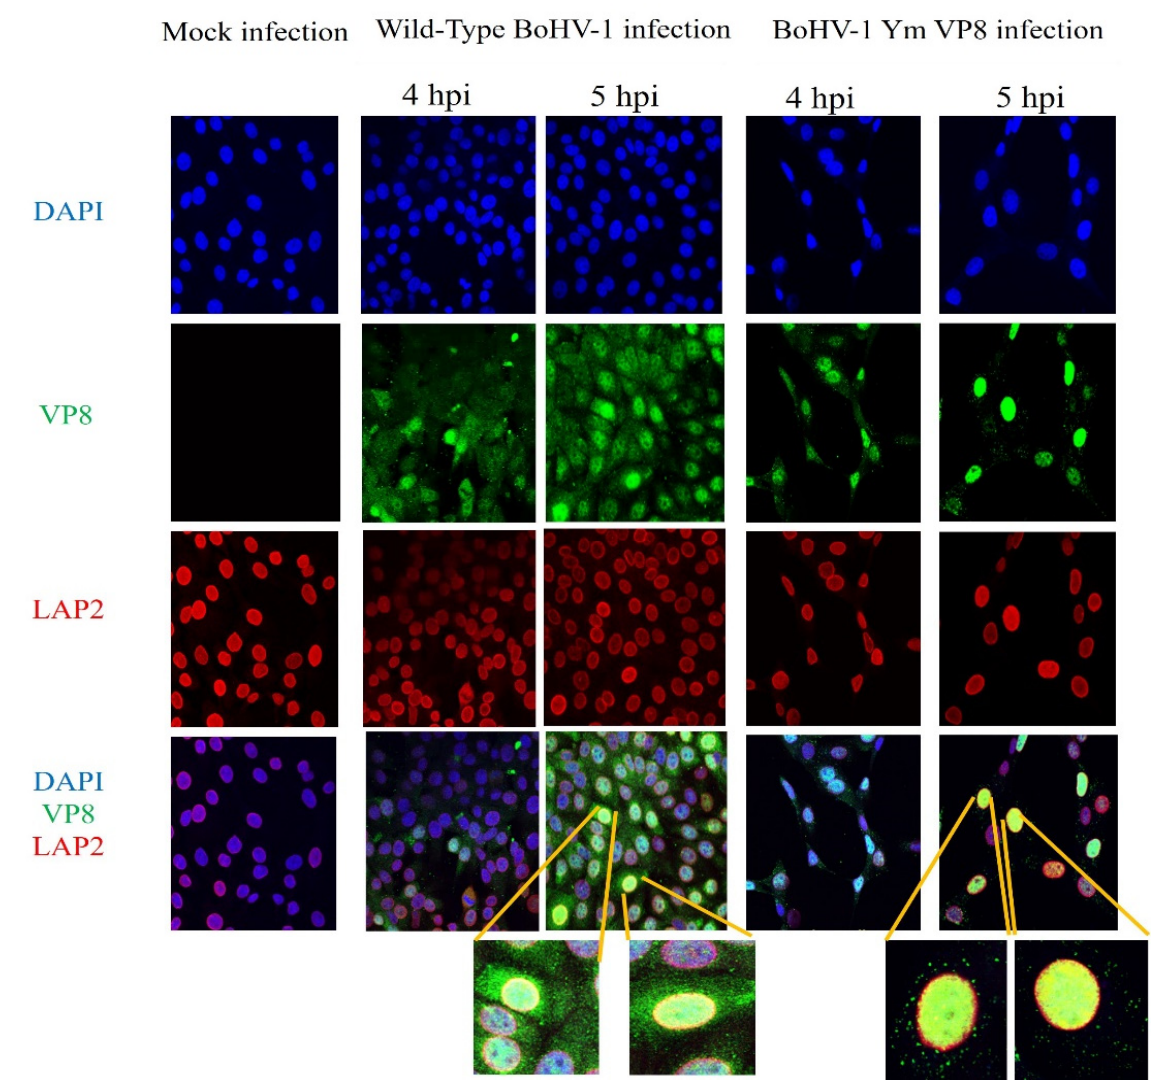
Figure 8. Co-localisation of VP8 and LAP2. MDBK cells were infected with wild-type BoHV-1 or BoHV-1YmVP8 at an MOI of 5, and fixed and permeabilised at 4 or 5 h post-infection. VP8 was identified with rabbit VP8-specific antibody and Alexa-488-conjugated goat anti-rabbit IgG. LAP2 was detected with monoclonal LAP2-specific antibody and Alexa-633 conjugated anti-mouse IgG. The yellow ring around the cells shows VP8 co-localised with LAP2 in the perinuclear region. Select cells were observed at 10× magnification to show more details.